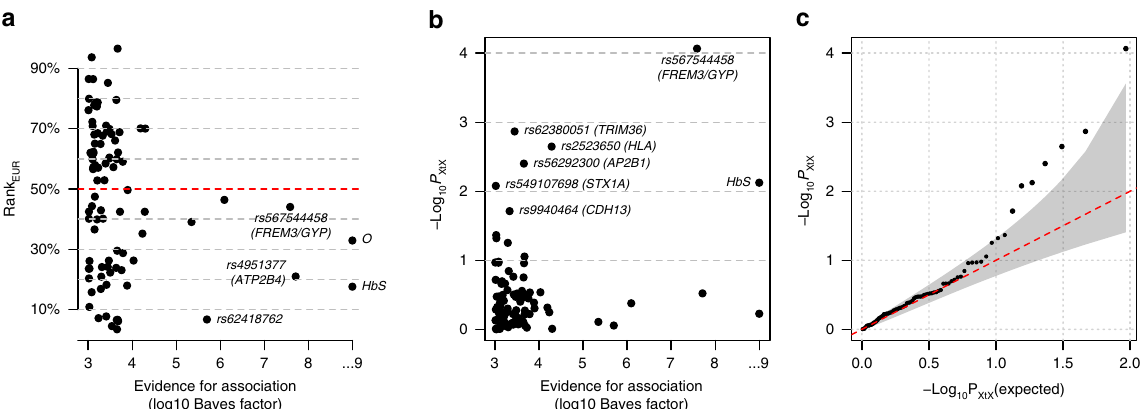
Fig. 7 Empirical evidence for frequency differentiation of the most associated alleles. a The European population rank (rank EUR , y axis) plotted against the evidence for association (log10 BF avg , x axis) for the protective allele at each of the 91 lead variants satisfying BF avg > 1000 and having assigned ancestral allele. For each variant with an estimated protective (respectively risk) derived allele A , rank EUR is de fi ned as the proportion of alleles genome- wide having lower or equal (respectively greater than or equal) count than A in European populations, conditional on having the same frequency in African populations, estimated in reference panel populations. On average, rank EUR is expected to be equal to 50% (red dashed line). Points are labelled by the rsid and nearest or relevant gene(s), or by functional variant where known; O refers to rs8176719, which determines the O blood group. b Evidence for within- Africa differentiation ( P XtX, y axis) plotted against the evidence for association (log10 BF avg , x axis) for each of the 92 lead variants satisfying BF avg > 1000, after removing all but rs2523650 from within the HLA region. P XtX is computed from an empirical null distribution of allele frequencies learnt across control samples in the seven largest African populations (Supplementary Figs. 8 and 9). c Quantile – quantile plot for P XtX across the top 92 regions in b . Source data are provided as a Source Data fi